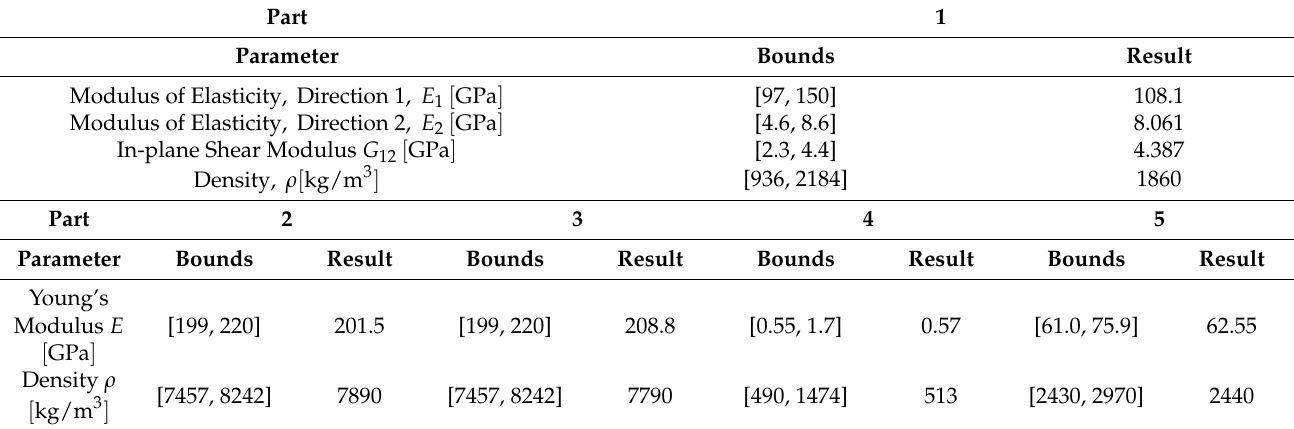
Table 4. Updated FE model material properties.